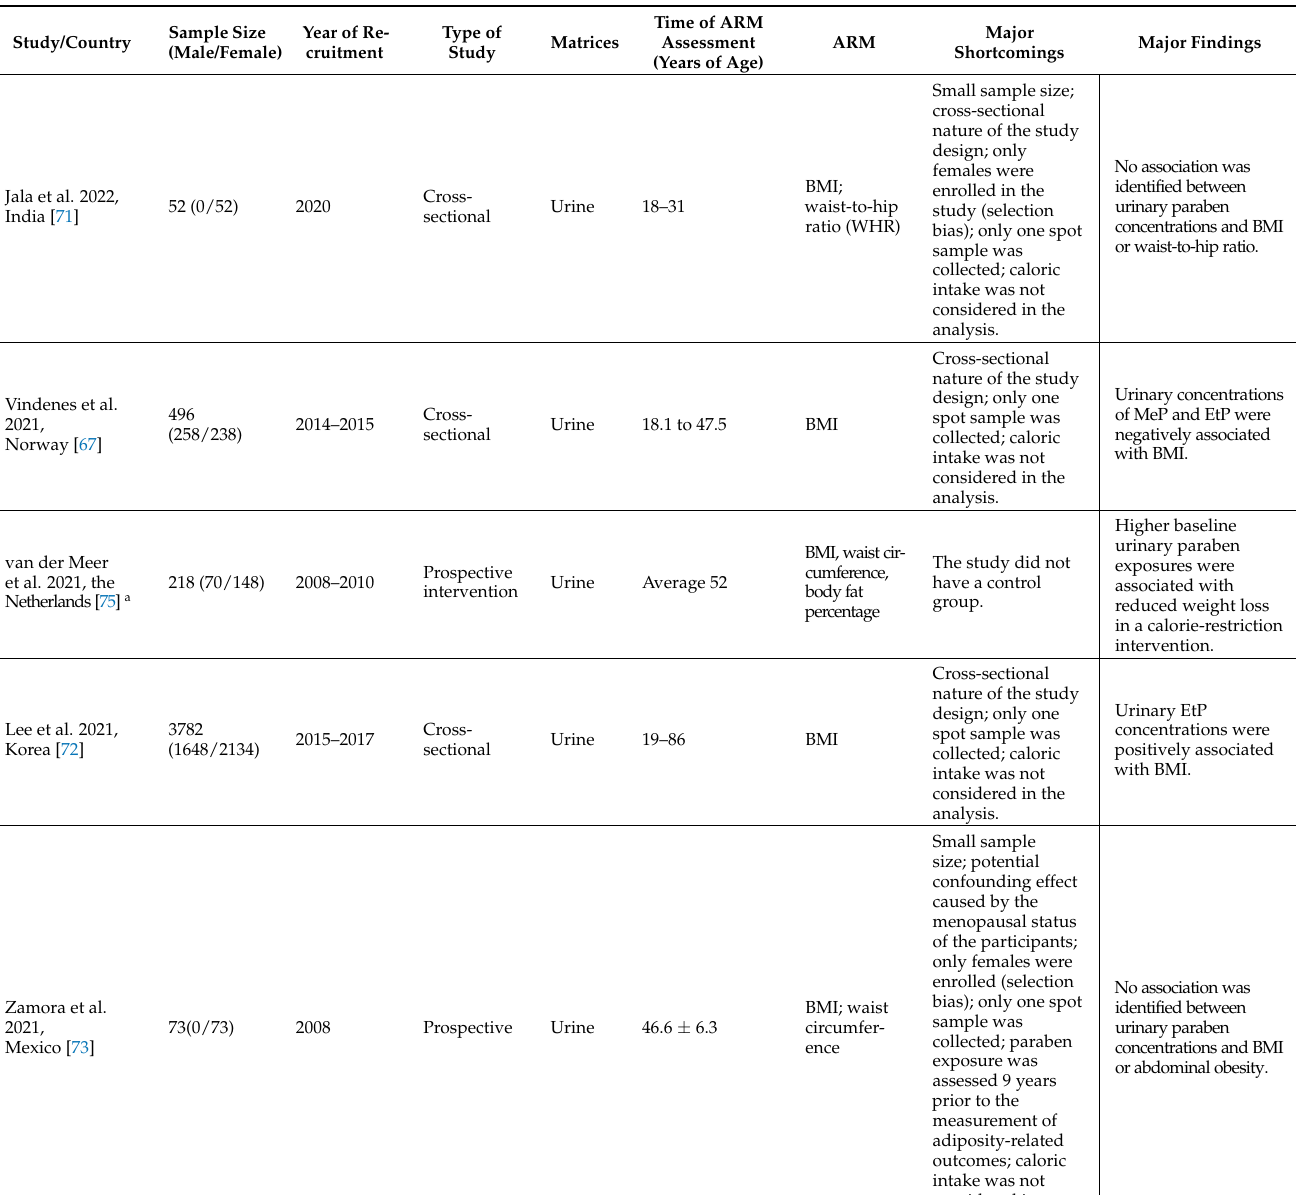
Table 3. Association of paraben exposure during adulthood and adiposity-related measures